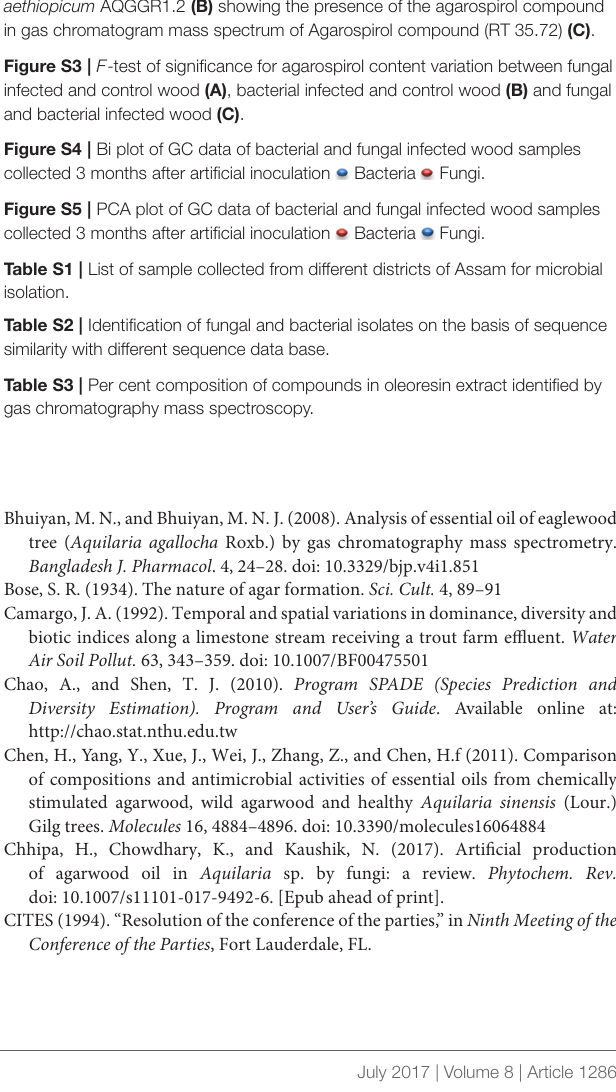
Figure S1 | Site map of the districts selected for sample collection. Figure S2 | GC-MS profile of oil extracted from artificial infected wood dust sample inoculated with Pantoea dispersa AQGWDB1 (A) and Penicillium